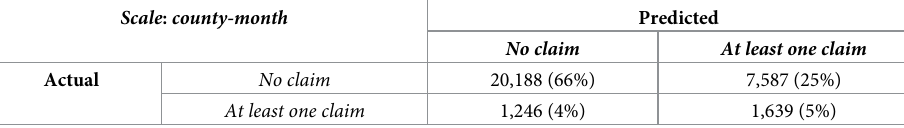
Table 1. Out-of-sample confusion matrix for monthly-county records in 2016. This matrix sums together each of the 2,555 counties’ confusion matrices. Scale :